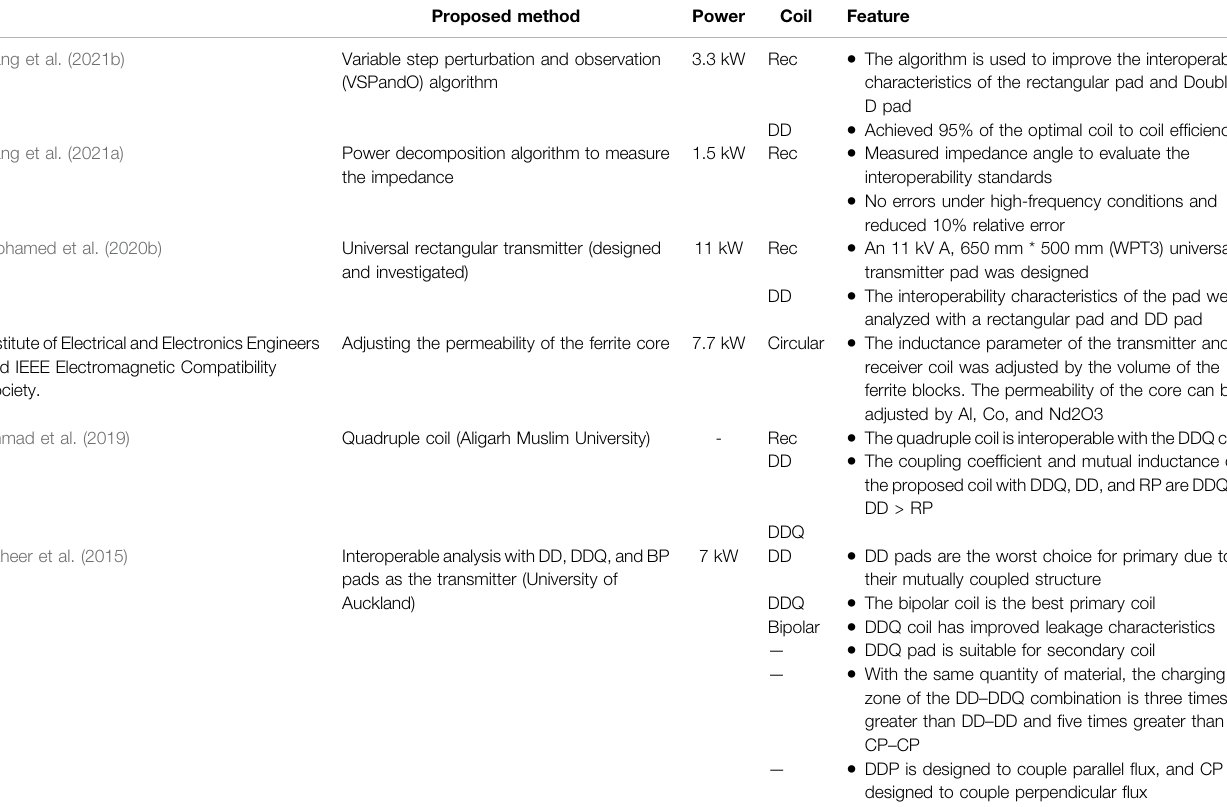
TABLE 3 | Analysis of